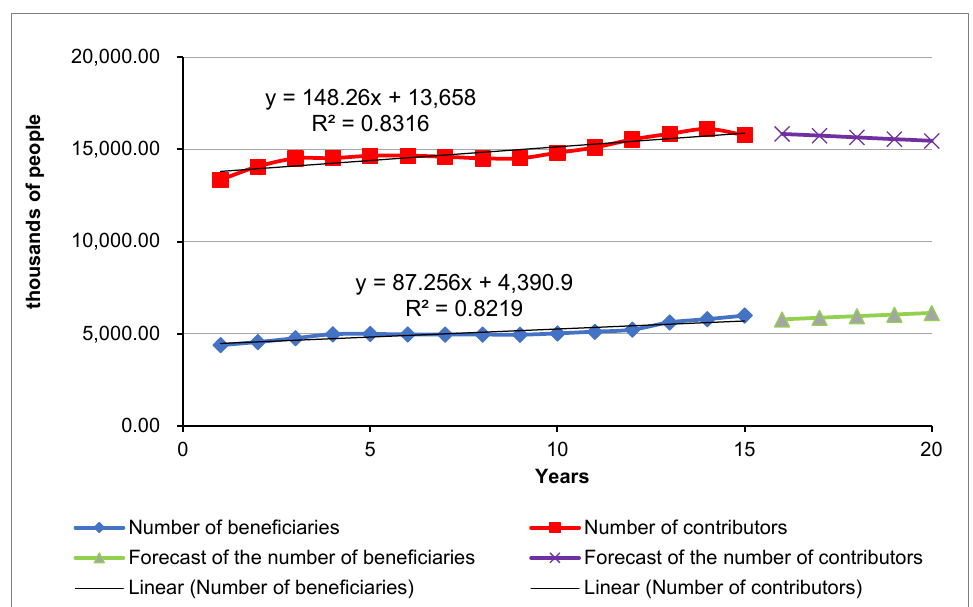
Figure 1. Number of contributors and beneficiaries of the Polish pension insurance system prognosis (2006–2025)*. *—year 1 is 2006, year 20 is 2025. Source: Own calculations based on Statistical Yearbook of Social Insurance.